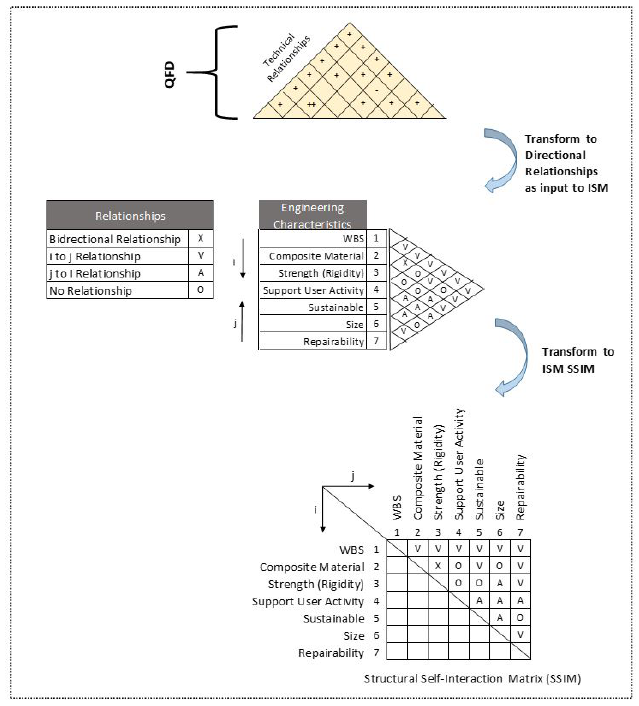
Figure 26. SSIM from HOQ2 Eng. Characteristics. The SSIM was converted to adjacency (Figure 27) and reachability (Figure 28) matrices as shown in Figure 27.